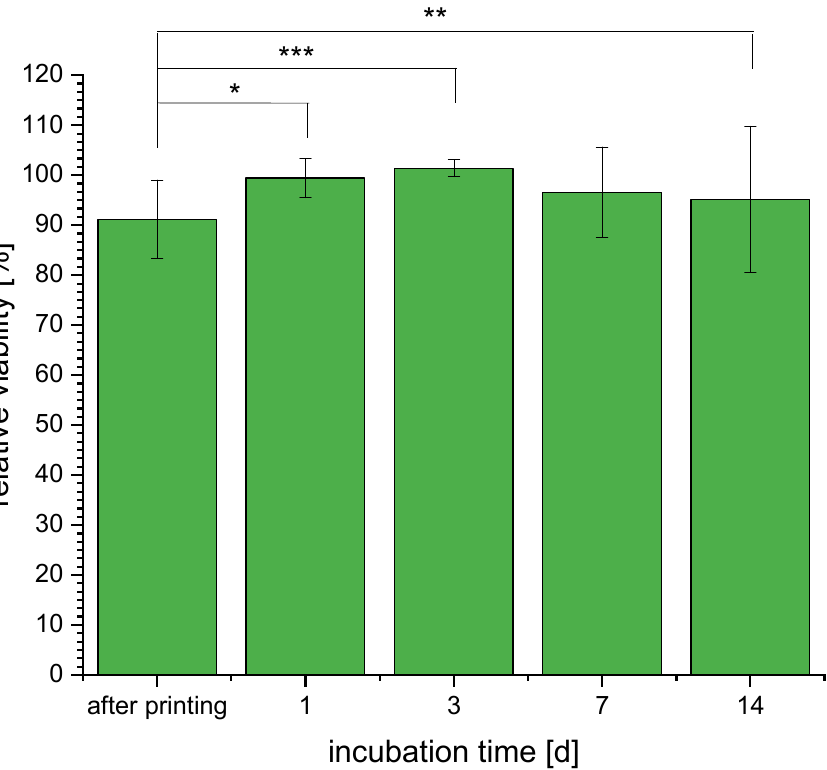
Figure 8. Viability of cells directly after printing and at several time points thereafter compared with viability before printing (set at 100%) determined in a live/dead cell staining assay. Data are means ± SD ( n = 4 grids, 3 images each; Kruskal–Wallis test, * p < 0.1, ** p < 0.05, *** p < 0.01). Transmitted light images were captured during the live/dead cell assay (Figure 9). The largest proportion of dead cells was found directly after printing (right corner), whereas fewer dead cells were detected over time. Meanwhile, the increasing green signal indicated cell expansion. The longer the incubation time, the more cells appeared within the bioink (the exposure time had to be reduced at day 14). The presence of round cell aggregates on day 7 indicated the formation of